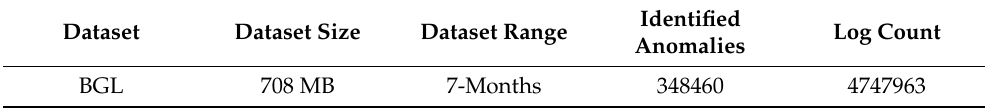
Table 2. Dataset